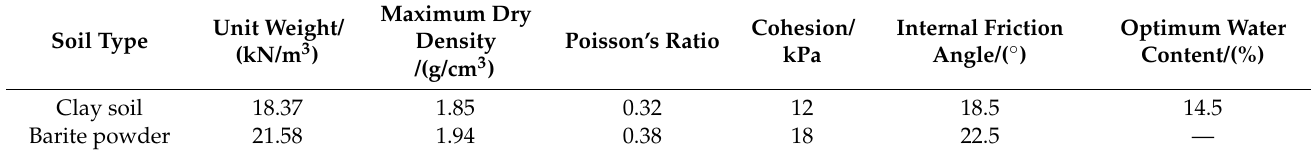
Table 2. Parameters of the